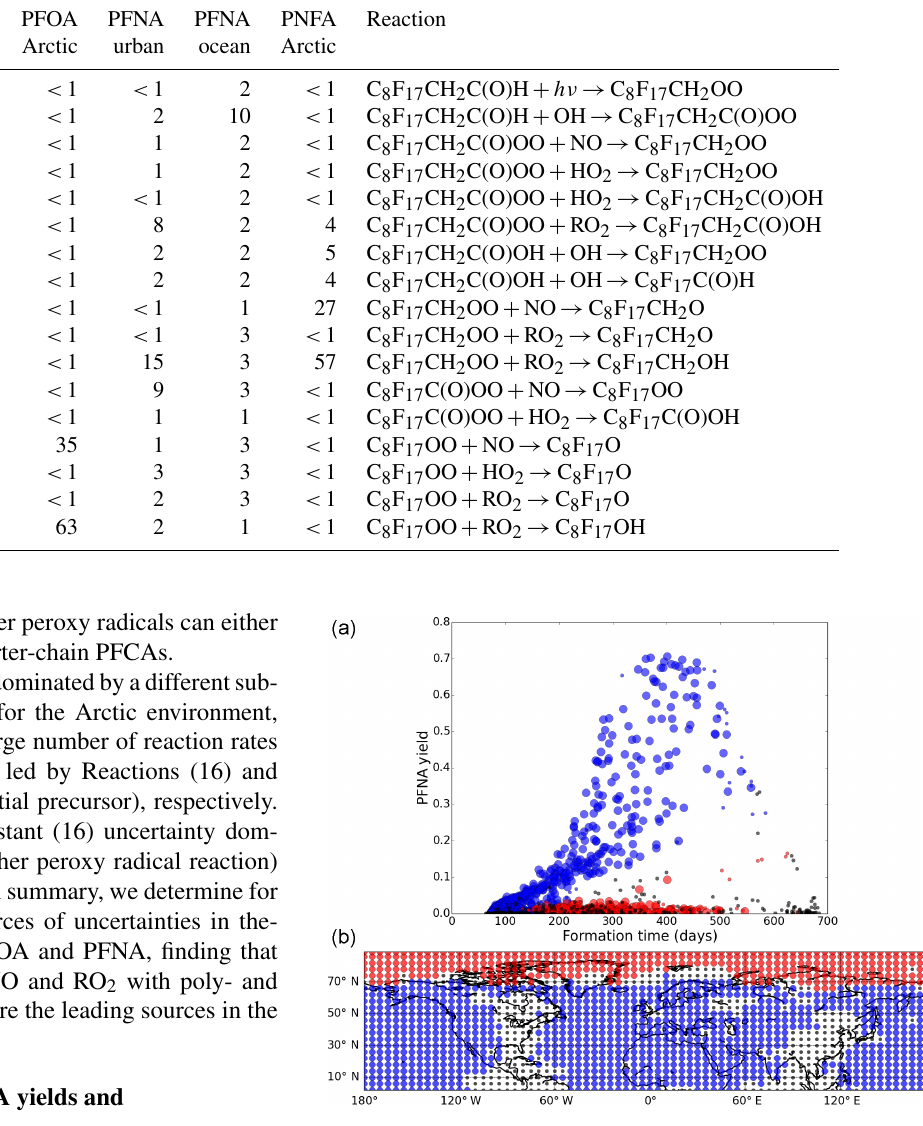
Figure 4. (a) Each photochemical environment plotted in yield- formation time space. Color indicates membership of a cluster in OH–HO 2 –NO space. Black circles indicate unclustered points. (b) Geographic location of clusters. Colors correspond to the same clusters in both